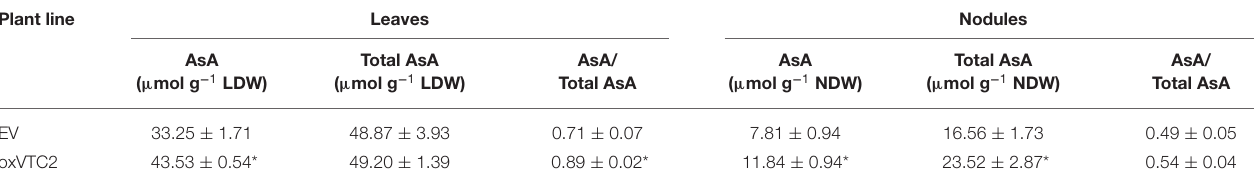
Values represent the average ± SE (n = 4 biological replicates). Asterisks ( * ) denote significant differences (p ≤ 0.05) using ANOVA test. LDW, Leaf dry weight; NDW, nodule dry weight.